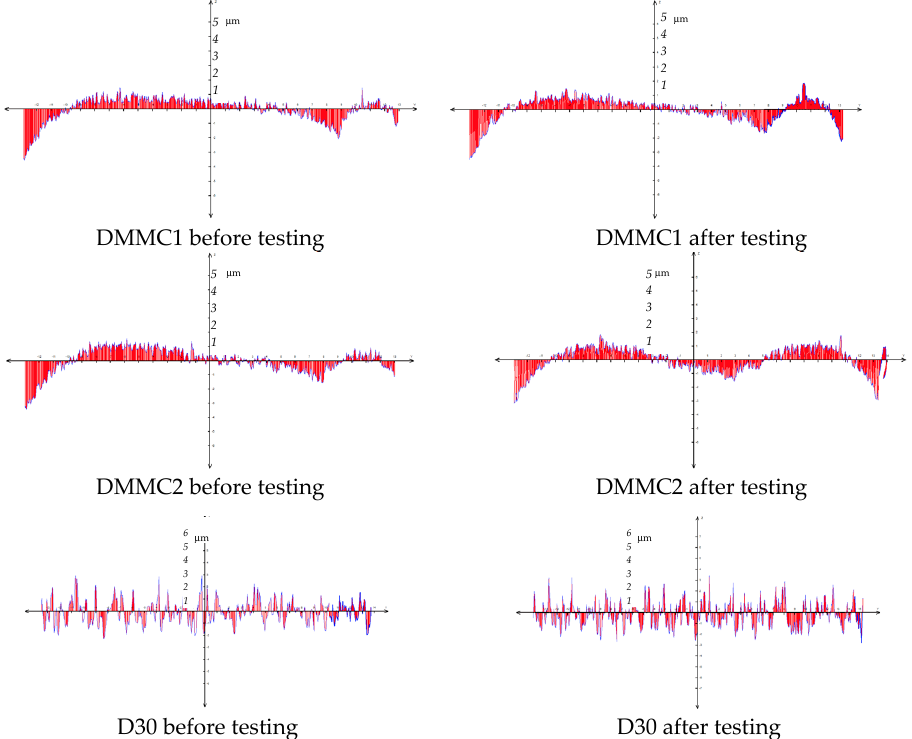
Figure 10. Diametral profile scan of disks before ( left ) and after ( right ) test (Y diameter direction).